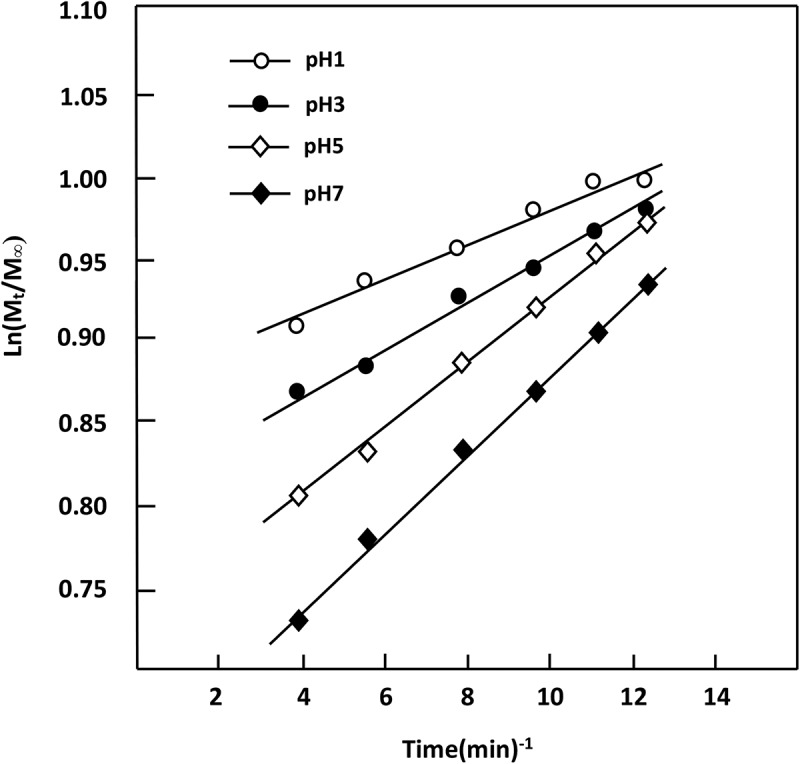
Variation of Ln (Mt/Mo) versus Ln(t) for the PAA-50 hydrogel.